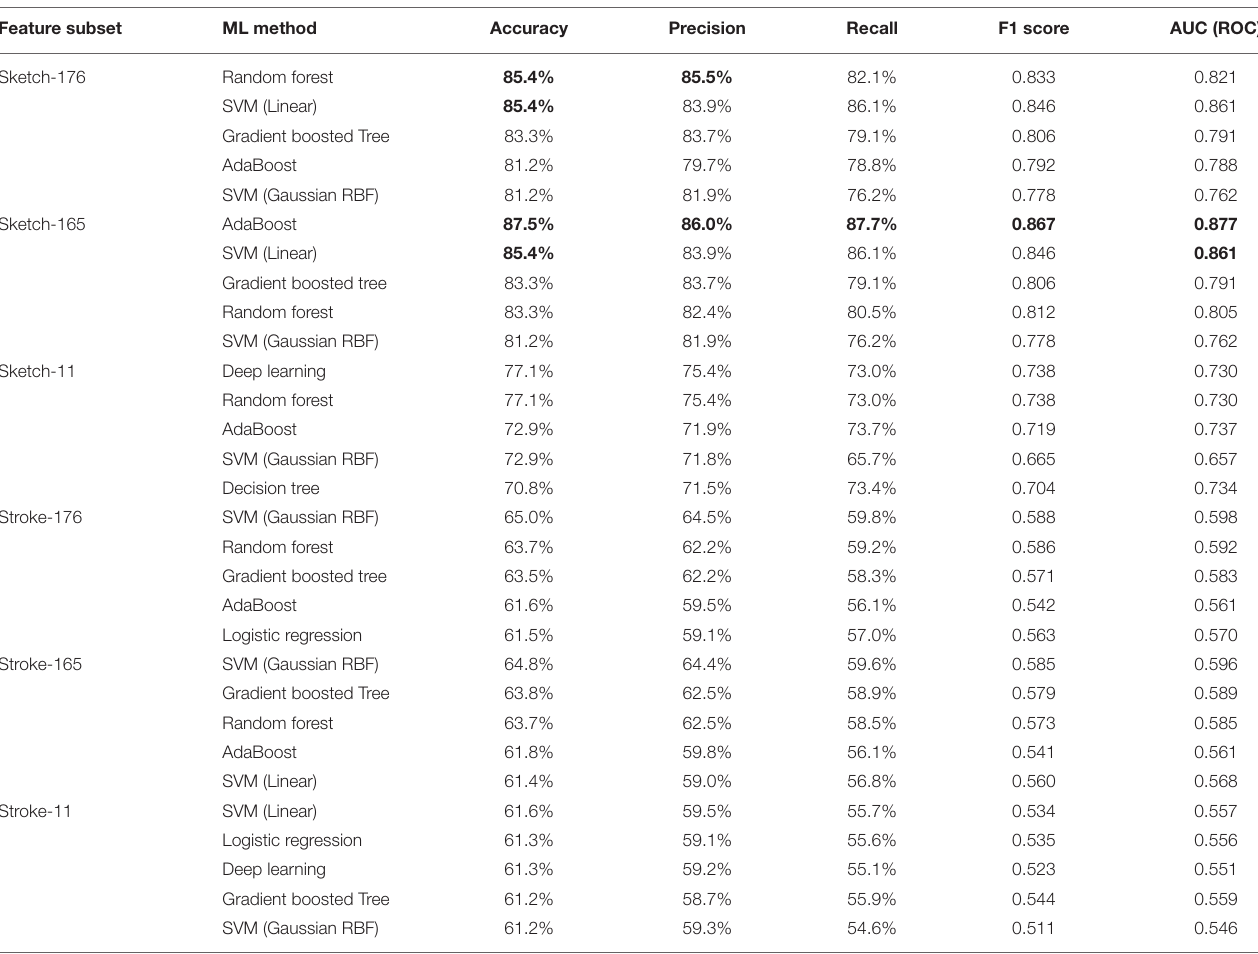
TABLE 2 | Top 5 ML methods for cognitive test performance classification per feature subset. Feature